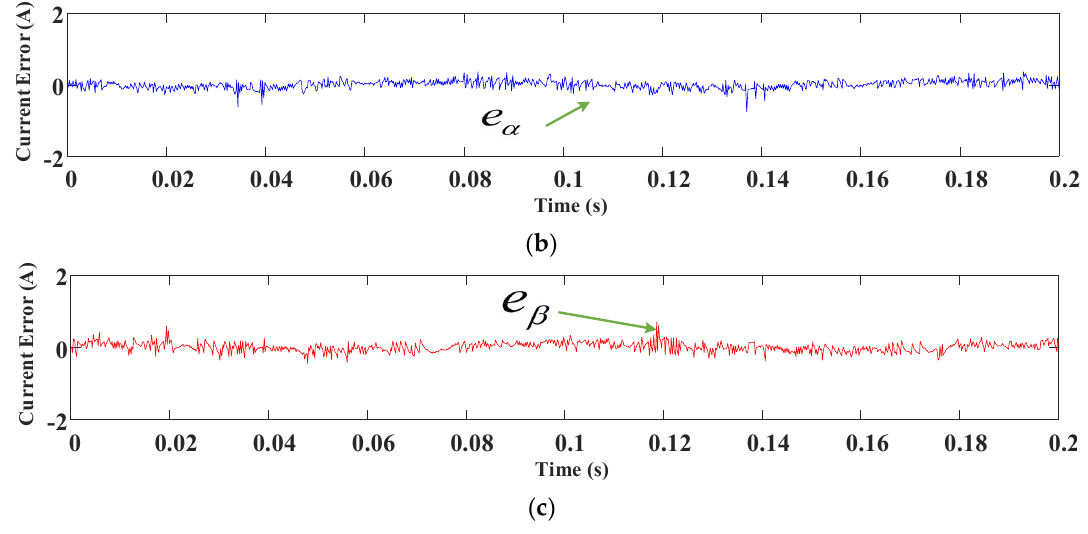
Figure 11. Experimental results of DVV-MFPCC under speed 300 rpm and load 2 Nm (case 1): ( a ) current responses; ( b ) α -axis current error; ( c ) β -axis current error.